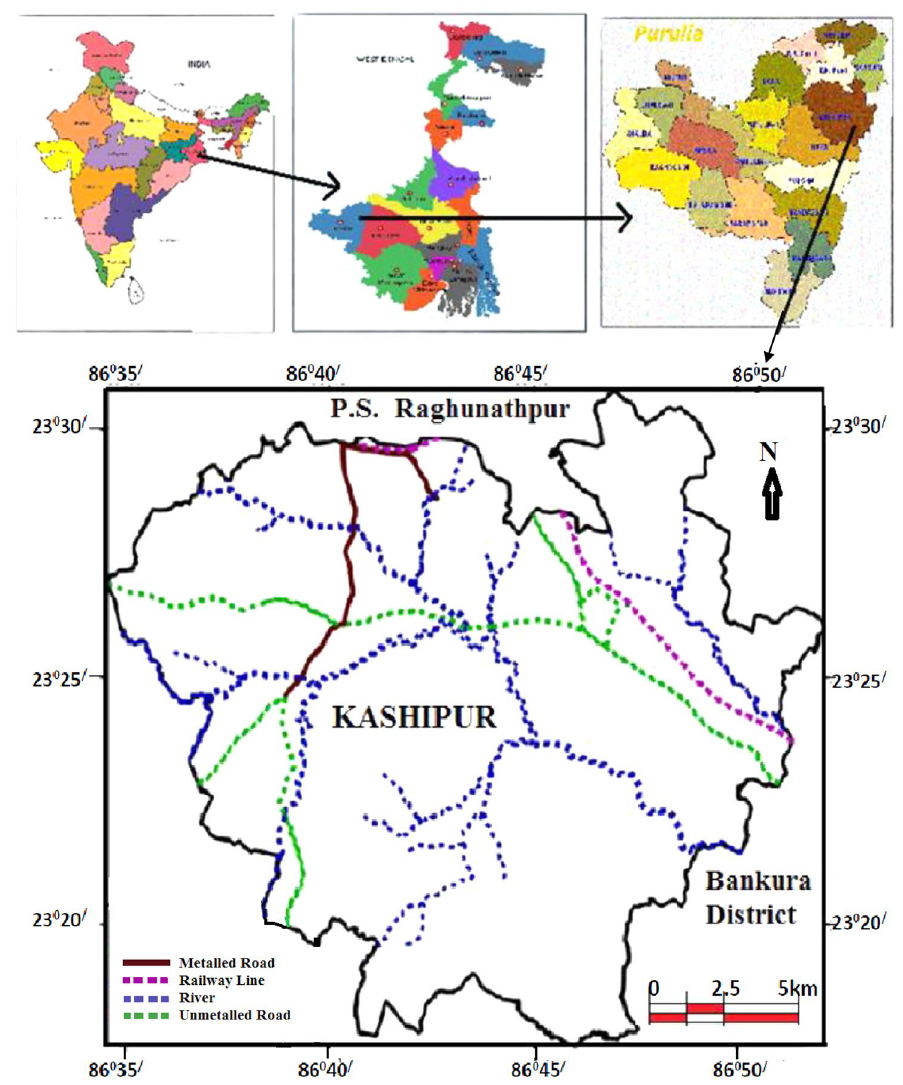
Fig. 1 Map of the study